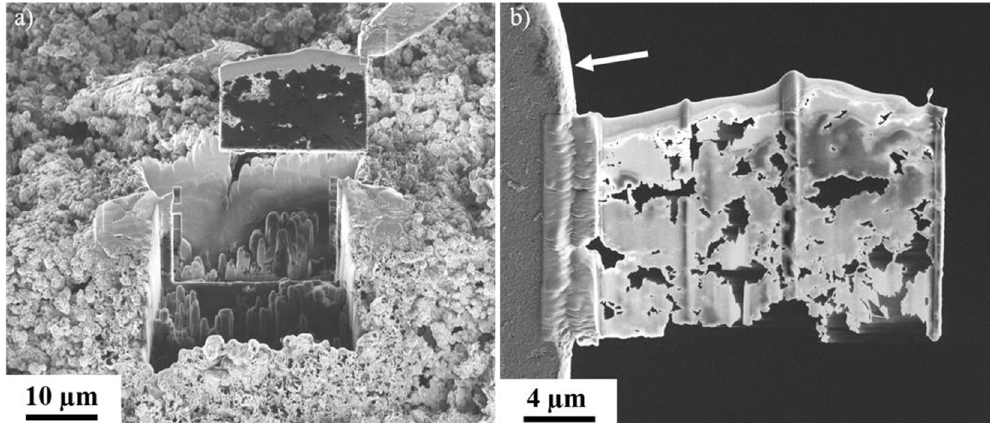
Figure 5. Production of FIB-lamella of MgCl 2 -flooded chalk: ( a ) cut-out of lamella from the sample surface, ( b ) thinned lamella welded to a copper grid (white arrow).